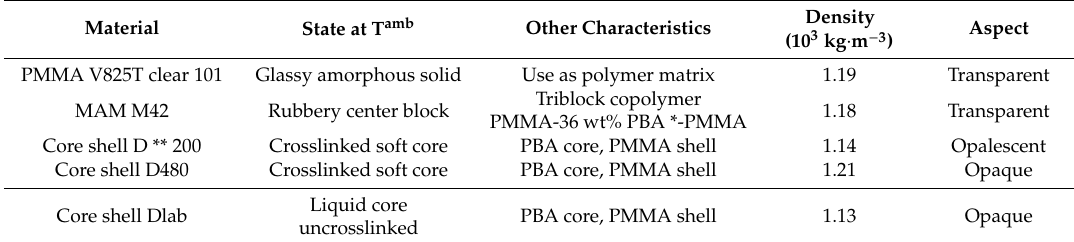
Table 5. Characteristics of the additives used in a PMMA